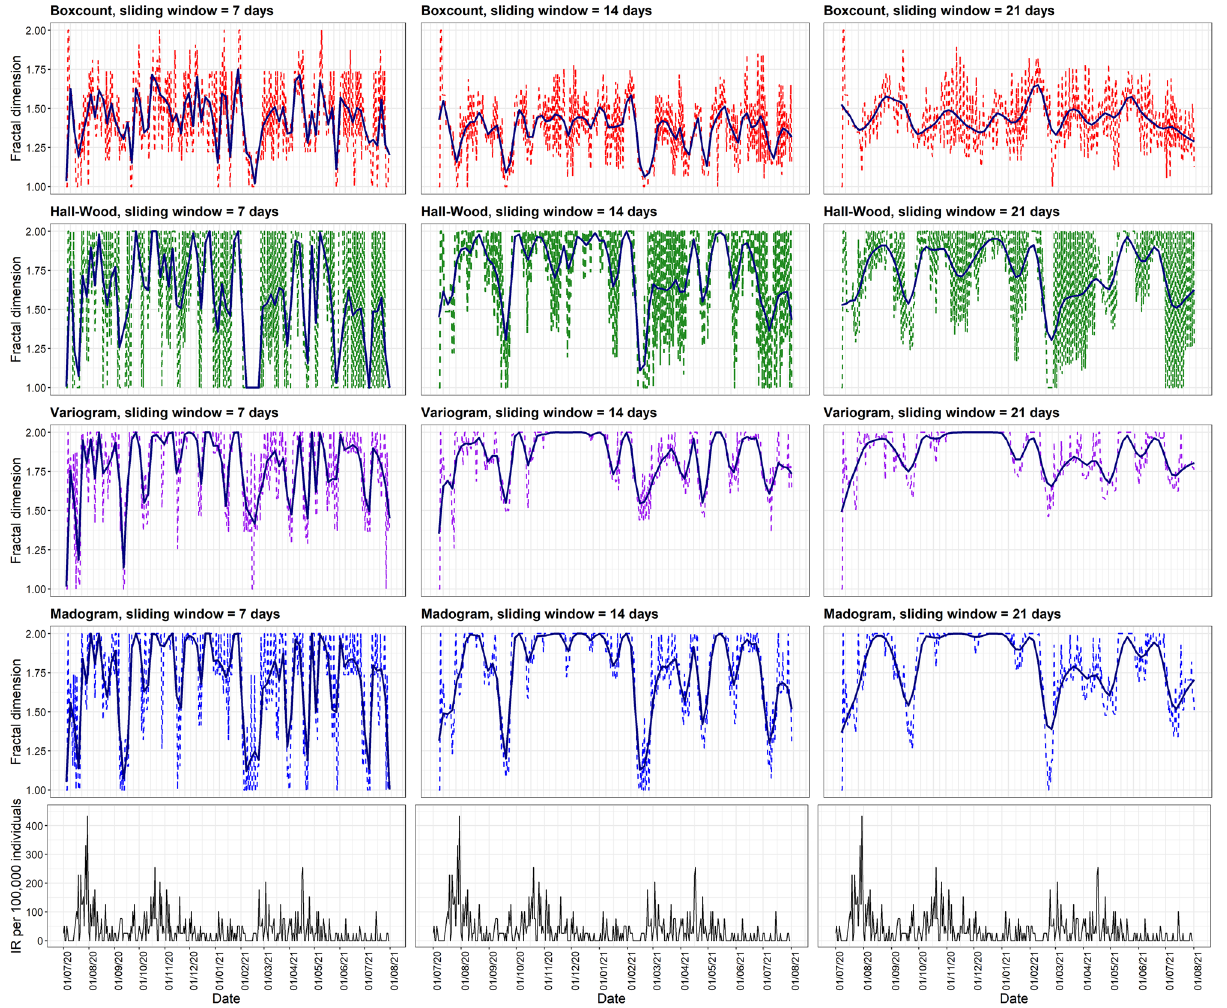
Figure 2. Local fractal dimension of COVID-19 incidence rate in De Peperbus , Antwerp. The raw fractal dimension value is depicted by the dashed line. Dark blue solid lines correspond to LOESS regression of the local fractal